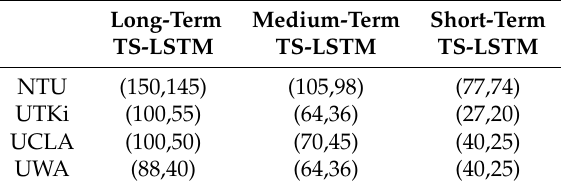
Table 1. Setting of parameters ( W l , TS l ) in the proposed MTA-RNN, TS-LSTM: Temporal Sliding Long Short Term Memory